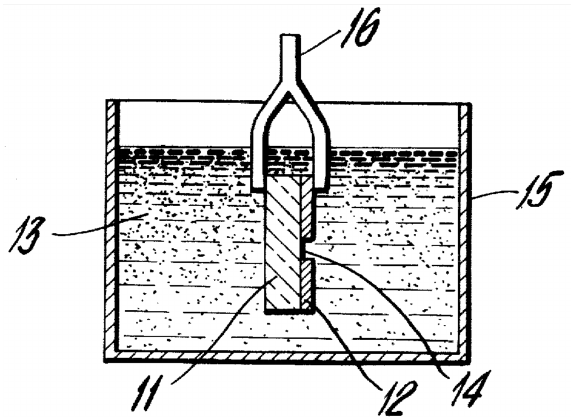
Figure 2. Schematic view of the ion-exchange process to fabricate a gradient-index channel waveguide in a glass substrate